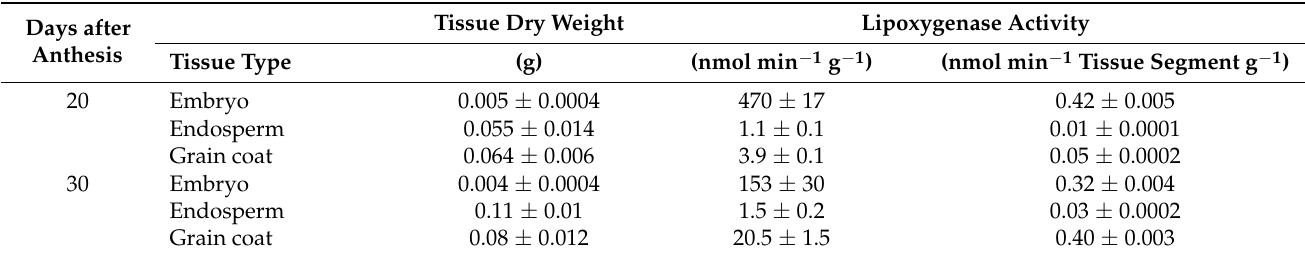
Table 3. Lipoxygenase activity in embryo, starchy endosperm and grain coat of Halberd sampled at 20 and 30 days. Activity was calculated both as per g dry weight and per tissue